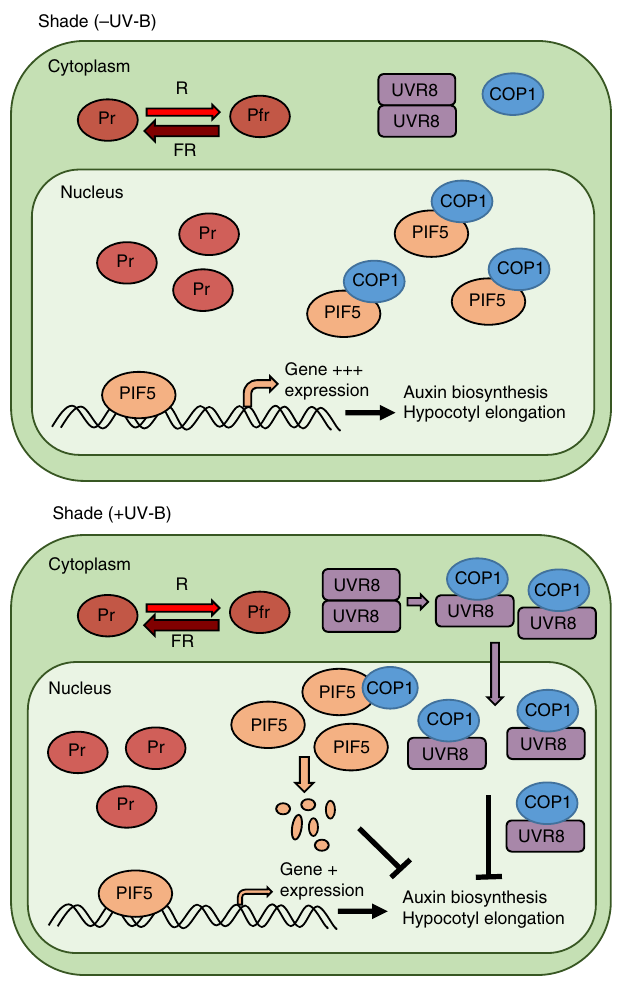
Fig. 6 Hypothetical model depicting how UVR8 regulates PIF5 abundance and hypocotyl elongation in low R:FR. When shaded, the photoequilibrium of phytochrome shifts towards the biologically inactive Pr form. This results in the stabilisation of PIF5 which is further enhanced by binding to COP1. PIF5 promotes the expression of genes involved in auxin biosynthesis and hypocotyl elongation. When sunlight is reached, UVR8 dimers absorb UV- B, causing them to monomerise and bind COP1. UVR8-COP1 complexes enter the nucleus and promote UV-B signalling which inhibits auxin biosynthesis and hypocotyl elongation via multiple mechanisms (Hayes et al. 2014). In addition, the sequestration of COP1 by UVR8 destabilises PIF5, further suppressing hypocotyl light responsiveness of COP1 sub-cellular localisation in addition to their role in promoting COP1 activity 41 . Upon detection of sun fl ecks or emergence through the canopy, UVR8-mediated detection of UV-B promotes rapid degradation of PIF5 to limit shade avoidance and prevent unnecessary stem elongation once sunlight has been reached (summarised in Fig. 6). UVR8- mediated inhibition of PIF signalling via DELLA stabilisation 6 acts over a longer time frame to promote resource reallocation towards leaf development and photosynthesis in sunlight. The role of COP1 and SPA proteins in regulating PIF4 and PIF7 abundance/activity in low R:FR remains a key question for future research.